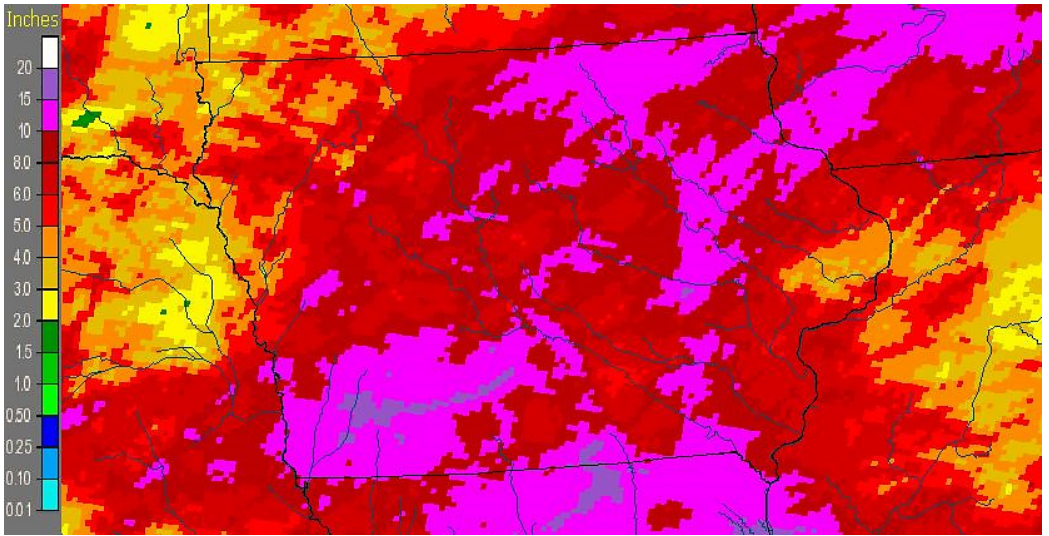
Figure 3. State of Iowa rainfall totals for the month of June 2008 [33].